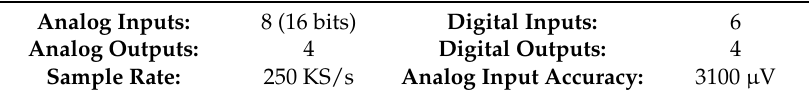
Table 4. Technical data of module National Instruments (NI) PXI 6230.